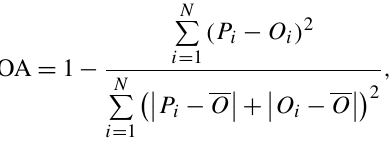
where P i and O i are the predicted and observed pollutant concentrations, respectively. N is the total number of the pre- dictions used for comparisons, and P and O represent the average of the prediction and observations,